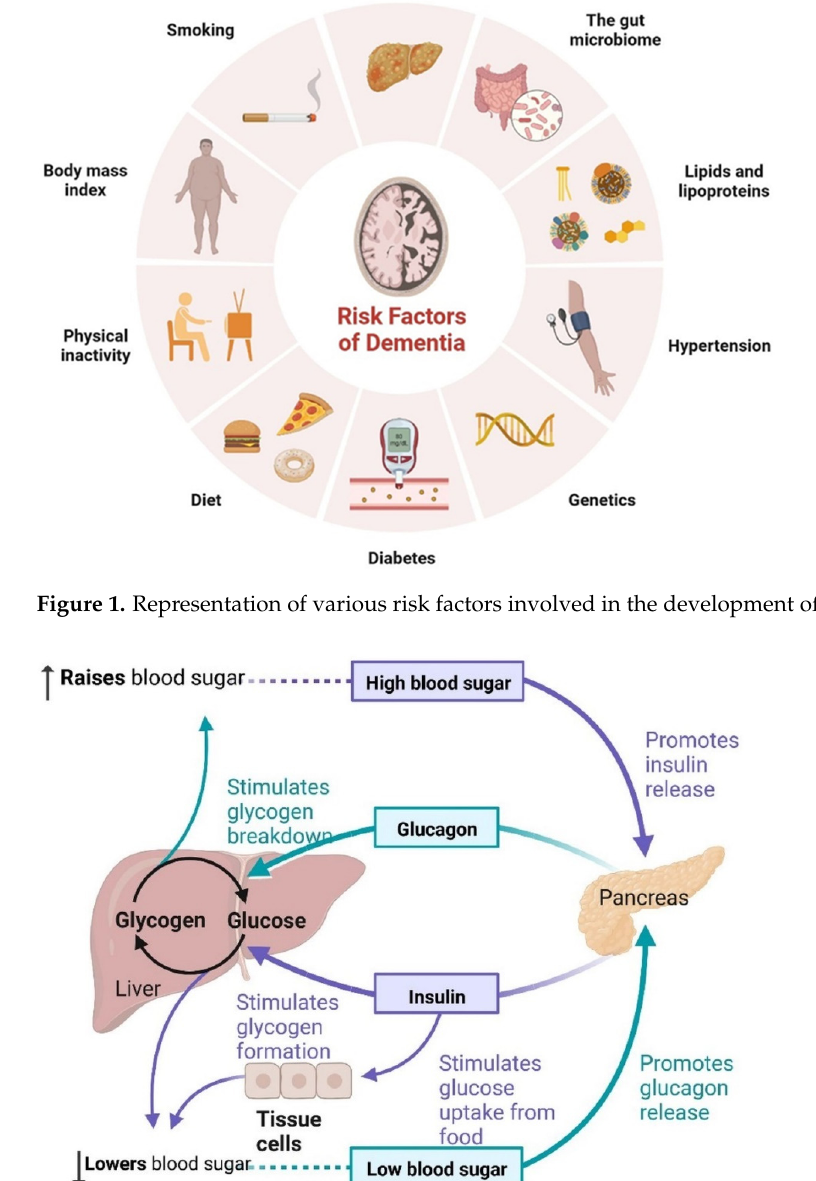
Figure 3. Proinsulin is transformed into insulin and C-peptide and stored in secretory vesicles, where it can be released when needed. Insulin is secreted by pancreatic beta cells to regulate glucose homeostasis. Through the GLUT transporters, glucose is freely taken in by the beta cell and metab- olized to produce ATP. This triggers a series of signals inside the beta cell that are required for glucose-induced insulin production. 2. T2DM and Dementia T2DM patients are 1.5–2.5-times more likely to develop neurological complications than people without diabetes. Insulin resistance (IR) is linked with Alzheimer’s disease (AD), and dysregulation in the molecular mechanism of insulin secretion may lead to his- topathological lesions in AD. Hyperglycemia is a major risk factor for cognitive impair- ment and dementia. Cognitive function may also be impacted negatively by hypoglyce- mia. IR is the major problem contributing to the emergence of clinical complications. The